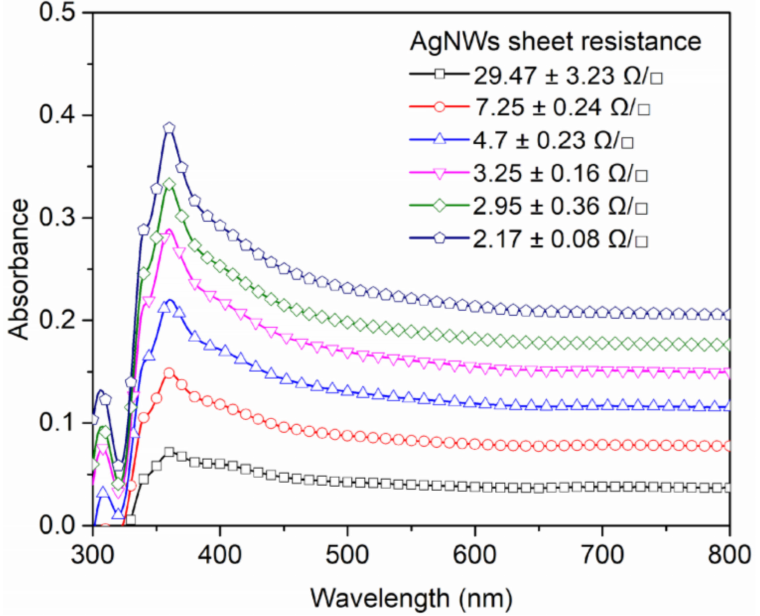
Figure 3. UV-Vis absorbance of AgNW network layers with different thickness and sheet resis- tance